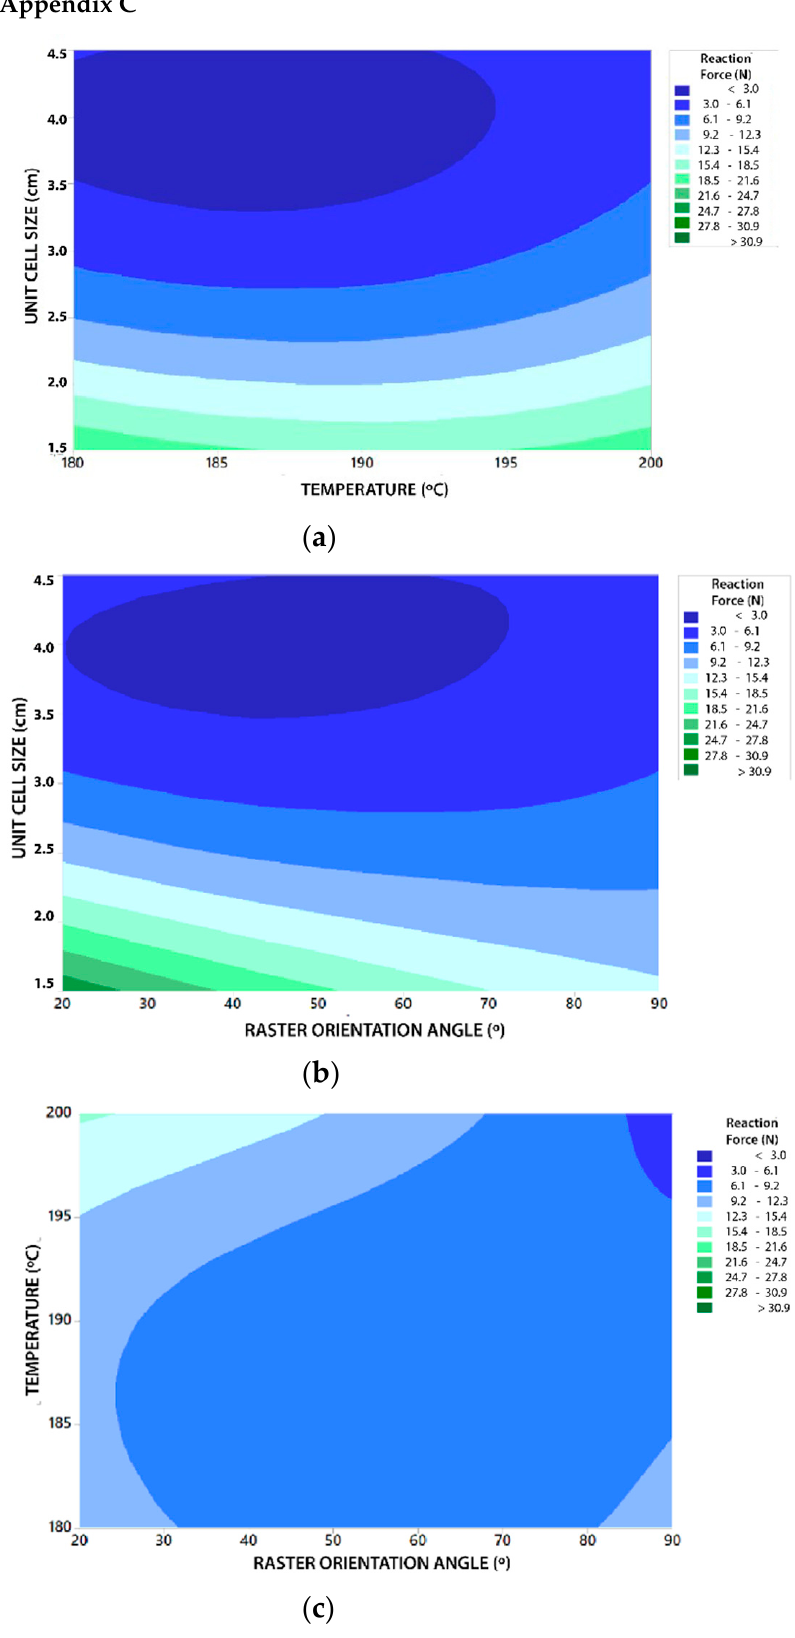
Figure C1. BCC contour plot; ( a ) Unit cell size (U) vs. Temperature (T); ( b ) Unit cell size (U) vs. Raster Orientation Angle (R); ( c ) Temperature (T) vs. Raster Orientation Angle (R).